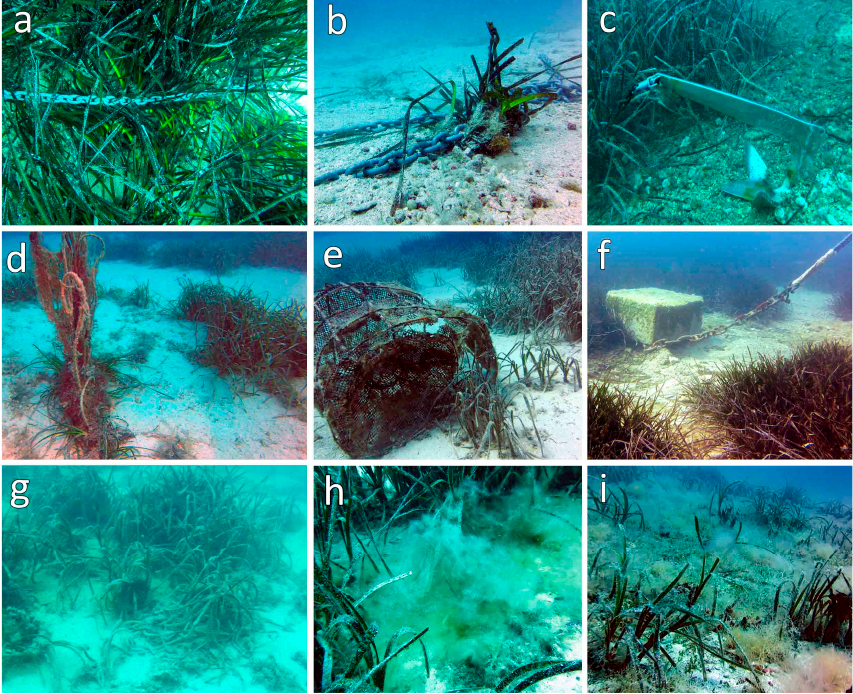
Figure 6. Main anthropogenic impacts affecting Posidonia oceanica at the Tremiti Islands. ( a ) Anchor chains on the meadow; ( b ) baring of P. oceanica bundles by anchor chain; ( c ) anchor on the meadow limit; ( d ) lost gillnet; ( e ) lost fishing trap; ( f ) abrasion of the chain on the seabed in a mooring system without a subsurface float between the anchor and the surface buoy; ( g ) burial of living bundles due to sedimentation; ( h ) mucilage on P. oceanica ; ( i ) settlement of Lophocladia lallemandii on a degraded P. oceanica meadow.